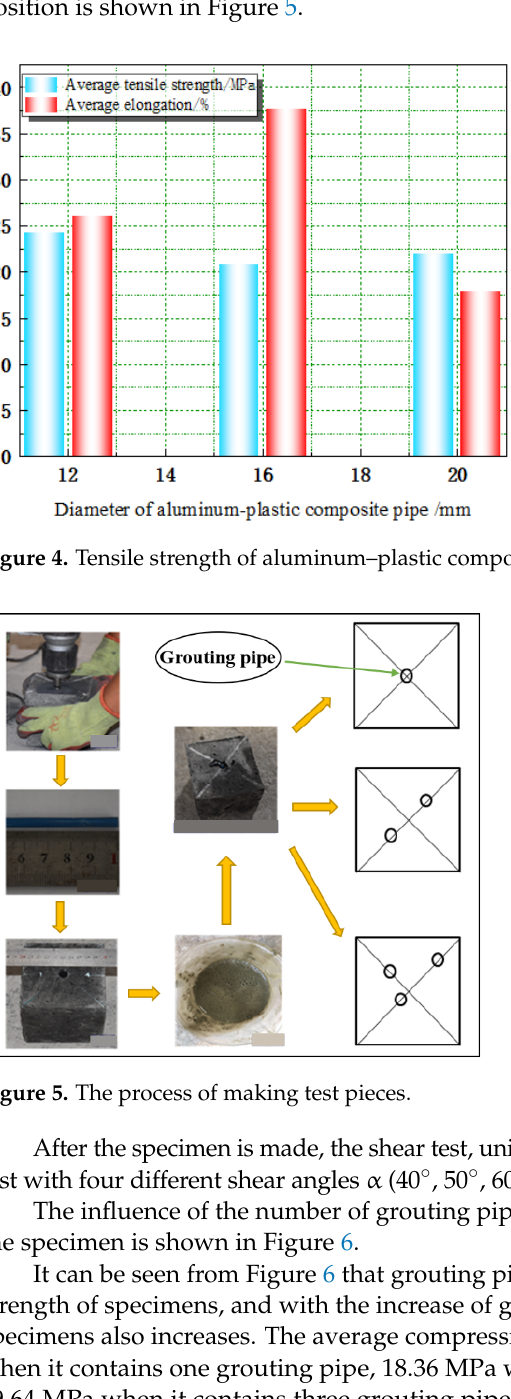
Figure 4. Tensile strength of aluminum–plastic composite pipes.